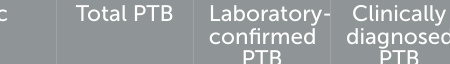
TABLE 1 Epidemiological characteristics of PTB cases among students in Zhejiang Province from 2007 to 2020 ( N =